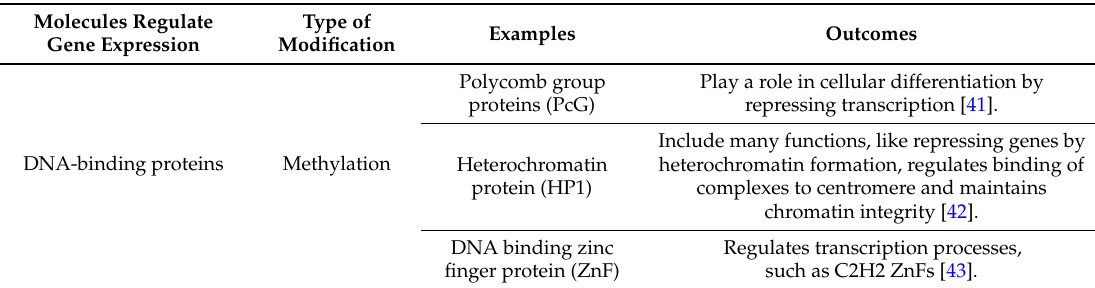
Table 3. Epigenetic regulations of gene expression by DNA binding proteins. Summary of the gene expression regulations by methylated DNA binding proteins, such as polycomb group proteins, heterochromatin proteins and DNA binding zinc finger